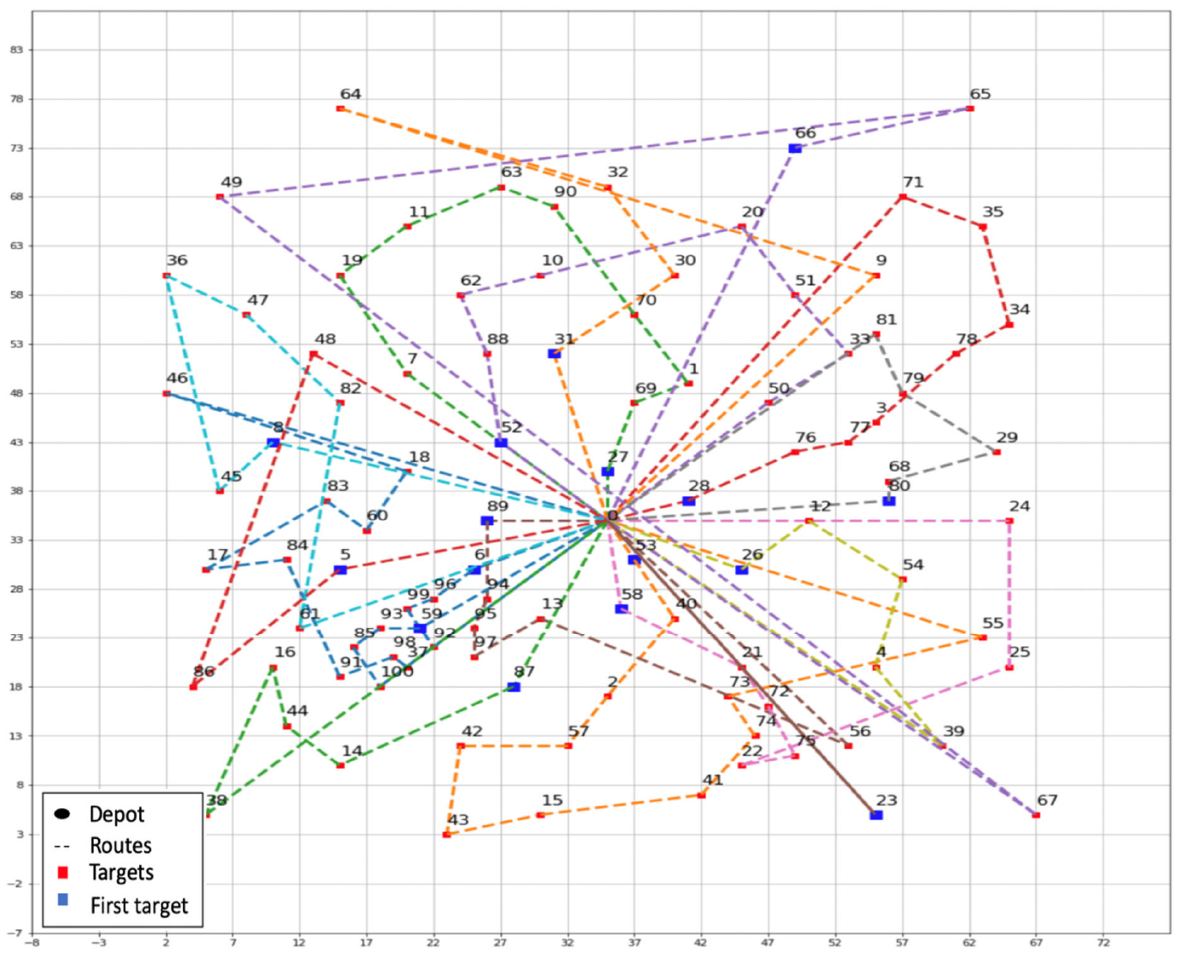
Figure 7. Improved solution of the GBDOH for instance E-n101-k14. Table 4. Initial and improved solutions of the GBDOH for instance E-n101-k14. Instance